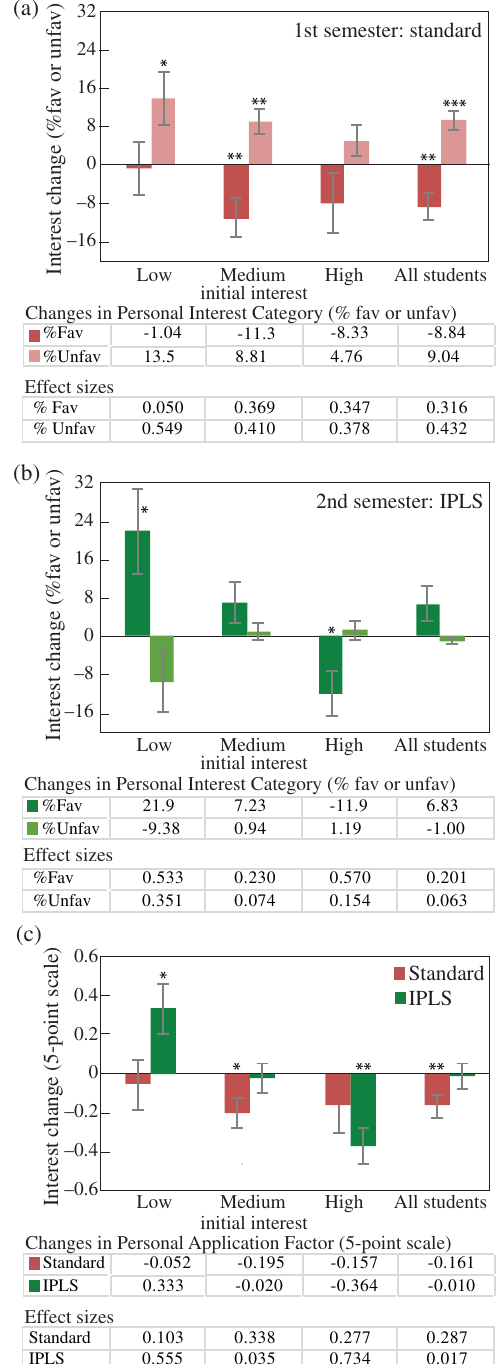
FIG. 2. Changes in student interest in physics (post-pre), measured using the CLASS Personal Interest category with % favorable and % unfavorable (a) for the standard first semester and (b) for the IPLS second semester, and (c) using the Personal Application Factor calculated on the 5-point scale. Results are shown both for the entire population and for low, medium, or high interest groups (Table IV). Asterisks indicate statistical signifi- cance (* p < 0 . 05 , ** p < 0 . 01 , *** p < 0 . 001 ); error bars show the standard error of the mean. Effect sizes were calculated using Cohen ’ s d . The corresponding data are provided in Table S1